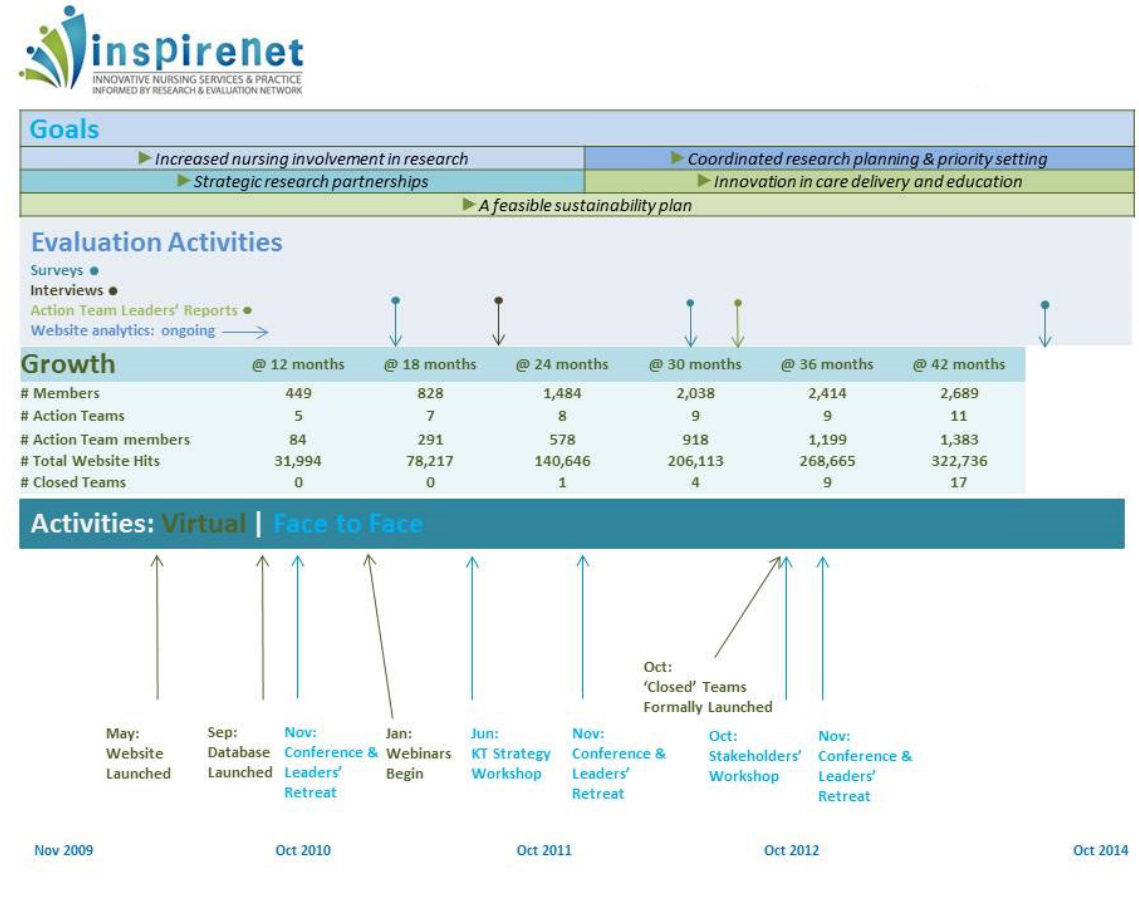
Figure 5. Timeline of growth and activities, June